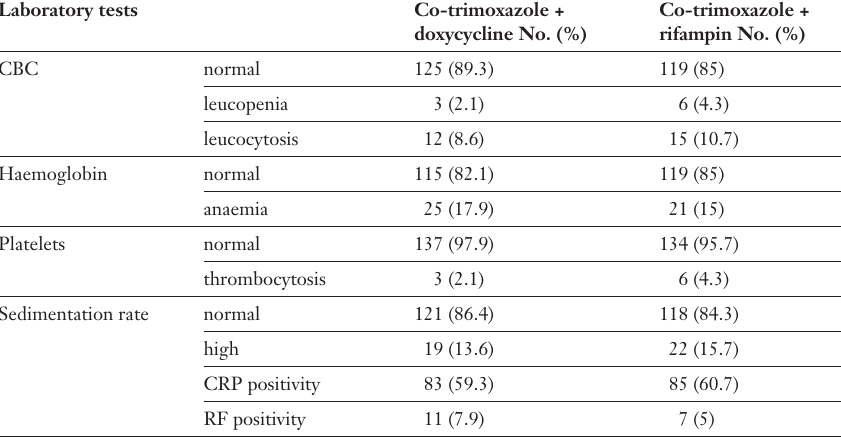
Laboratory test results in patients treated with co-tri- moxazole plus doxy- cycline or co-trimox- azole plus rifampin.